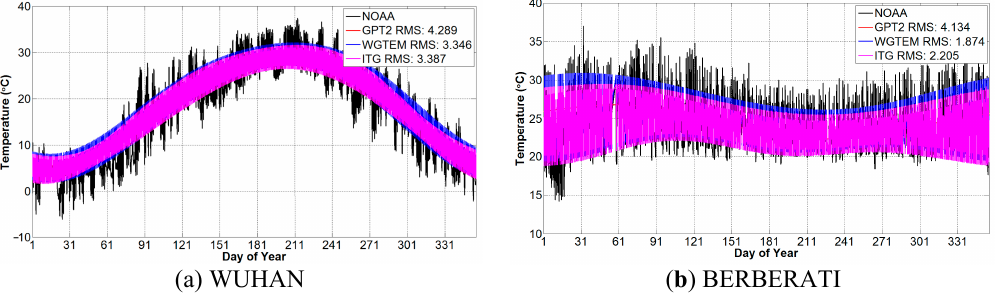
Figure 4. Temperature series in 2012 from NOAA, GPT2 model, WGTEM, and Improved Tropospheric Grid (ITG) model at two International GNSS Service (IGS) stations.